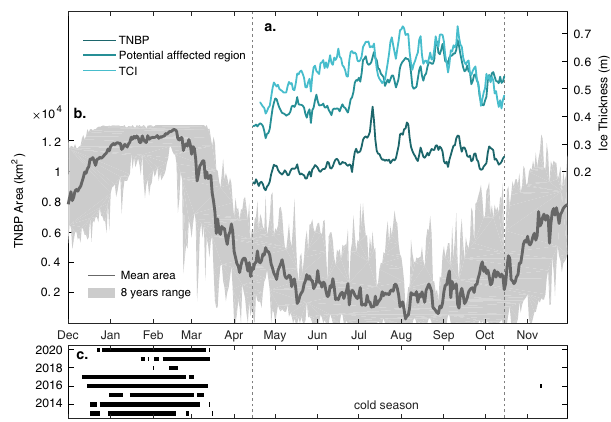
Fig. 5 Seasonal evolution of the TNBP area and the sea ice thickness of the transiting, the potentially affected region, and the TNBP. a Sea ice thickness in cold seasons from TNBP, the potentially affected region, and TCI. b Average TNBP area (grey line) with the range from 2013-2020 (grey shading). c Days of open water not surrounded by sea ice.